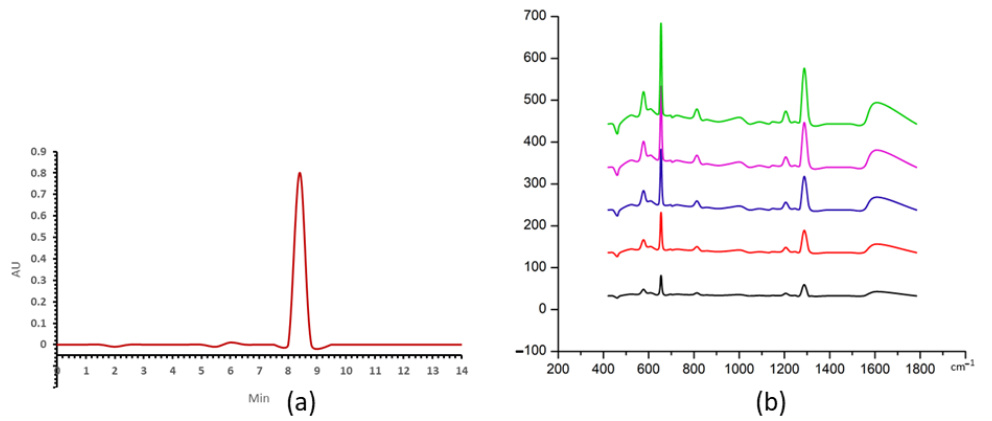
Figure 5. ( a ) The hypoxanthine HPLC peak of 250 ng/mL, ( b ) SERS spectra of hypoxanthine for concentrations at 50, 100, 150, 200 and 250 ng/mL in black, red, blue, purple and green, respectively.